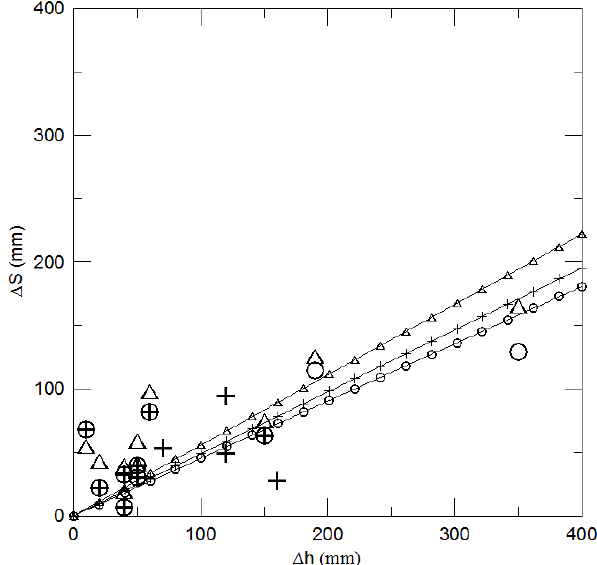
Figure 6. ∆ S versus ∆ h for well LE-PS17; ( △ ) no corrections applied, ( ⭘ ) with correction of Equation (1) and disaggregated values, (+) with correction of Equation (1) and aggregated values.